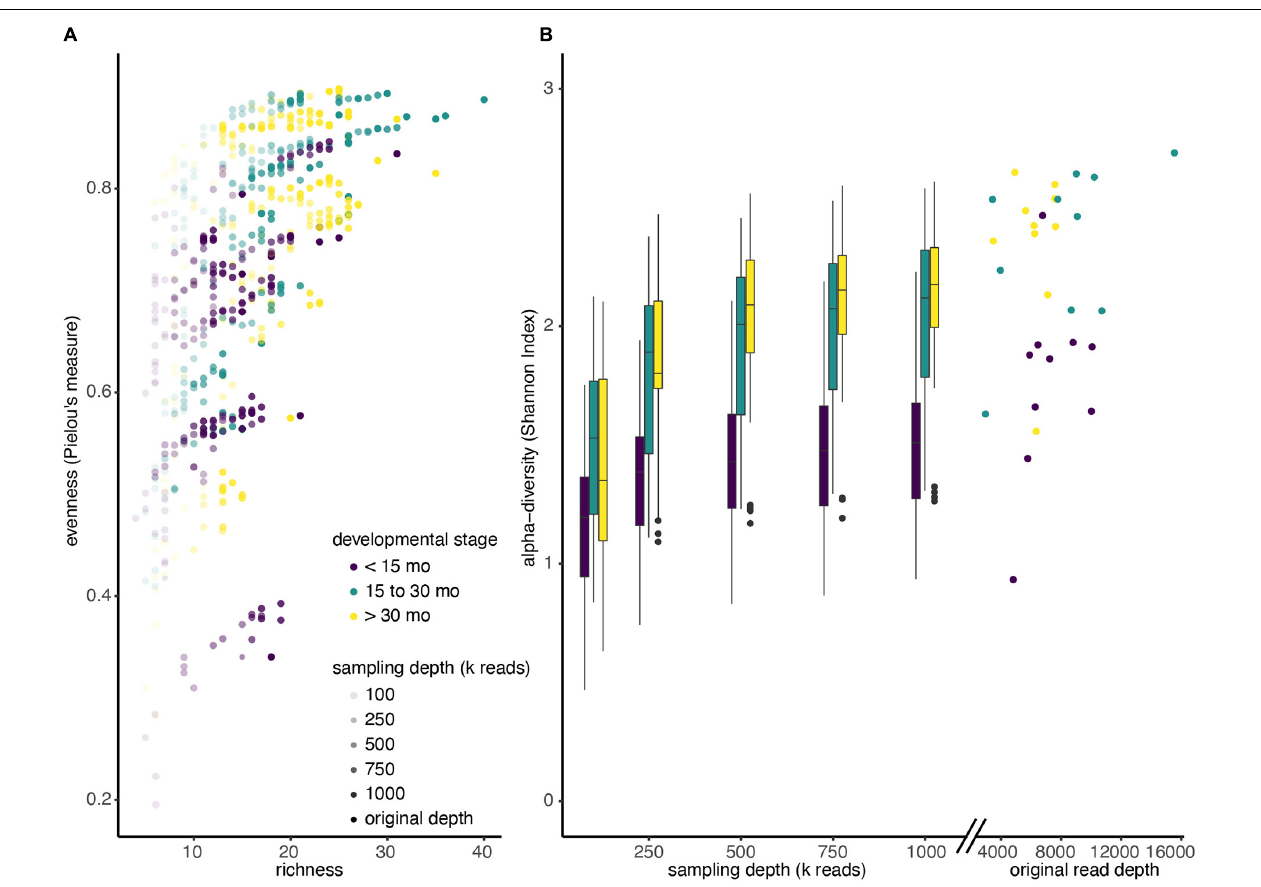
FIGURE 3 | Alpha diversity increases with sequencing depth. (A) Shotgun metagenomic reads from 30 deeply sequenced samples were resampled four times at each different sequencing depths (100k; 250k; 500k; 750k; 1M reads). Reads were reassigned taxonomy using MetaPhlAn and diversity was recalculated. Each dot represents a single resampled community. (B) Boxplots of Shannon diversity among all samples at each re-sampling depth, colored by developmental stage. Scatter plot indicates Shannon diversity of original samples.